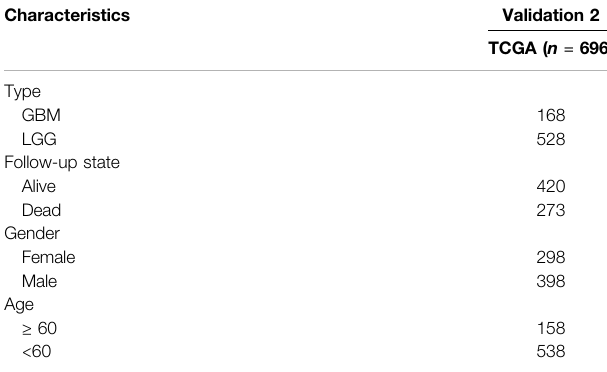
TABLE 1 | The clinical characteristics of glioma patients in CGGA. TABLE 2 | The clinical characteristics of glioma patients in